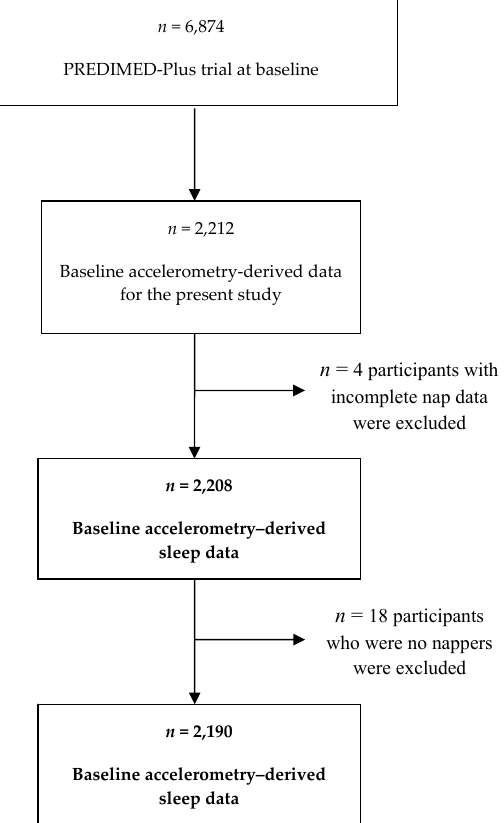
Figure 1. Flow-chart of study participants.